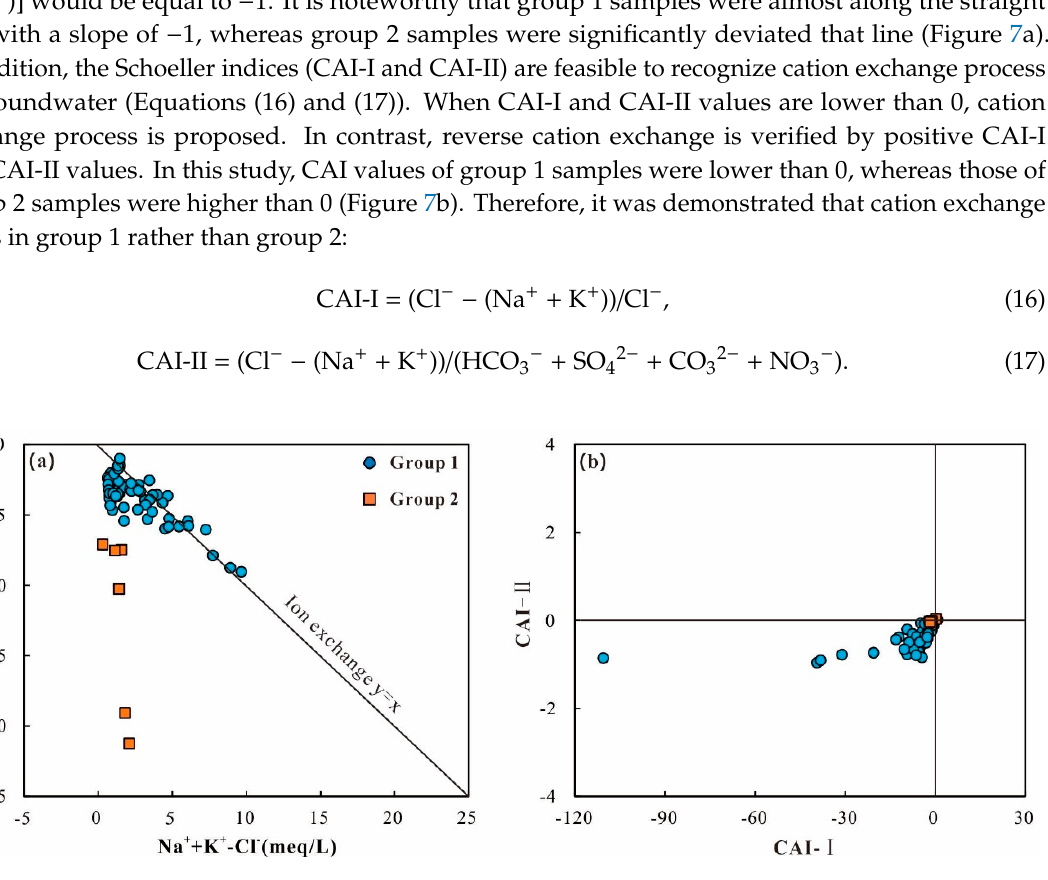
Figure 7. Plots showing ( a ) (Na + + K + − Cl − ) vs. (Ca 2+ + Mg 2+ − HCO 3 − − SO 42 − ), ( b ) CAI-I vs. CAI-II for groundwater samples (CAI-I and CAI-II are calculated in meq/L).